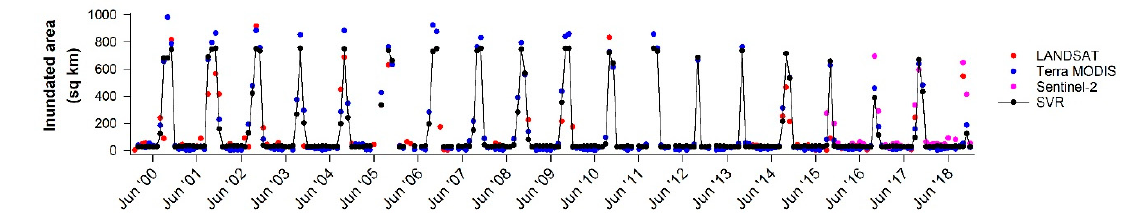
Figure 11. Reconstructed area of flood inundation using support vector machine regression (black).